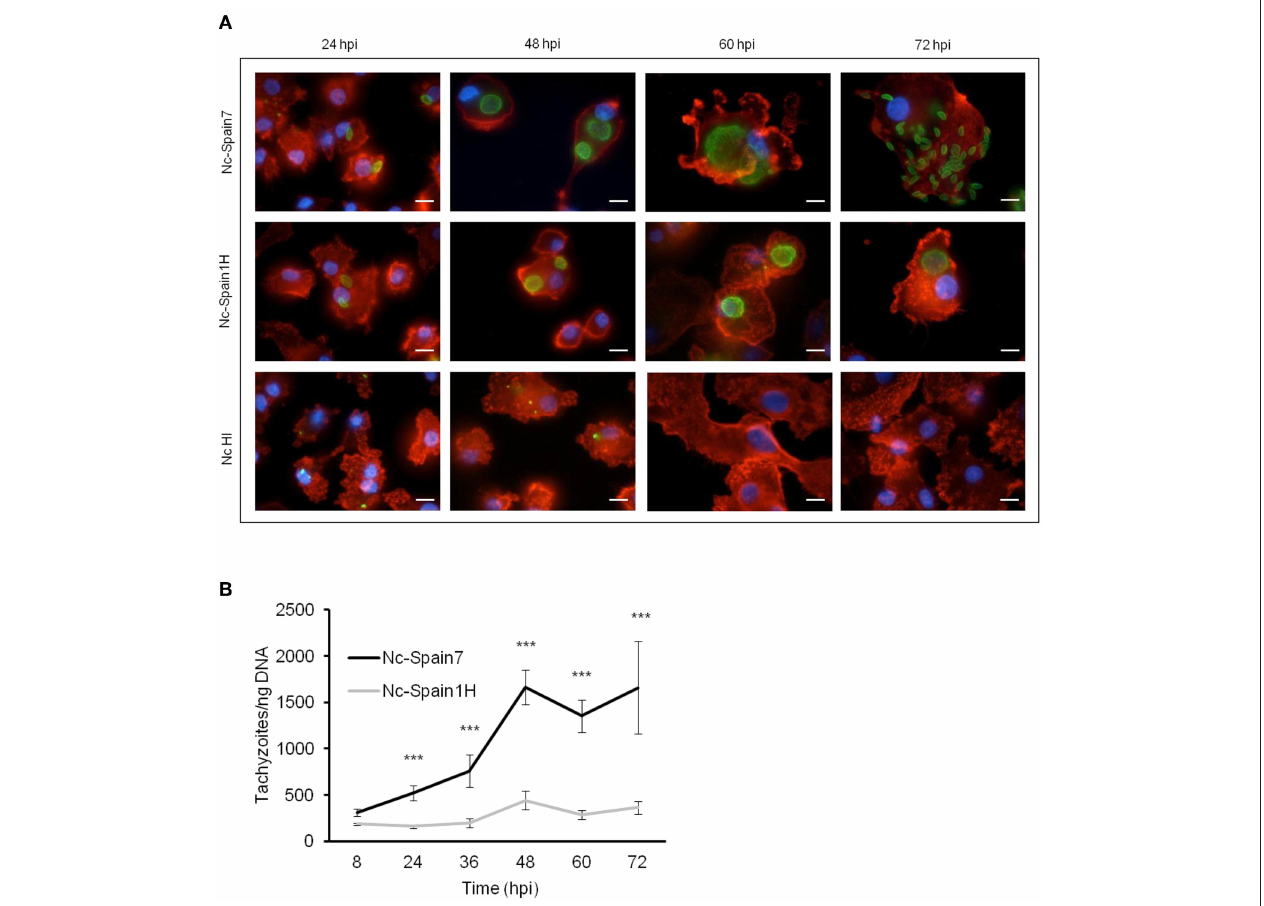
FIGURE 2 | Proliferation of Nc-Spain7 and Nc-Spain1H isolates in bovine MØs. (A) Representative images (at 1,000 × ) show the proliferation kinetics in MØs over time of Nc-Spain7 and Nc-Spain1H isolates and the degradation of HI tachyzoites in bovine MØs cultures. F-actin is presented in red, nuclei in blue and parasites in green. Scale bar is 10 µ m. (B) The graph represents the average number of tachyzoites for each time point assayed. The growth of Nc-Spain1H in bovine MØs did not fit the exponential growth equation. Error bars indicate the SD. Significant differences are indicated (*** p < 0.001).